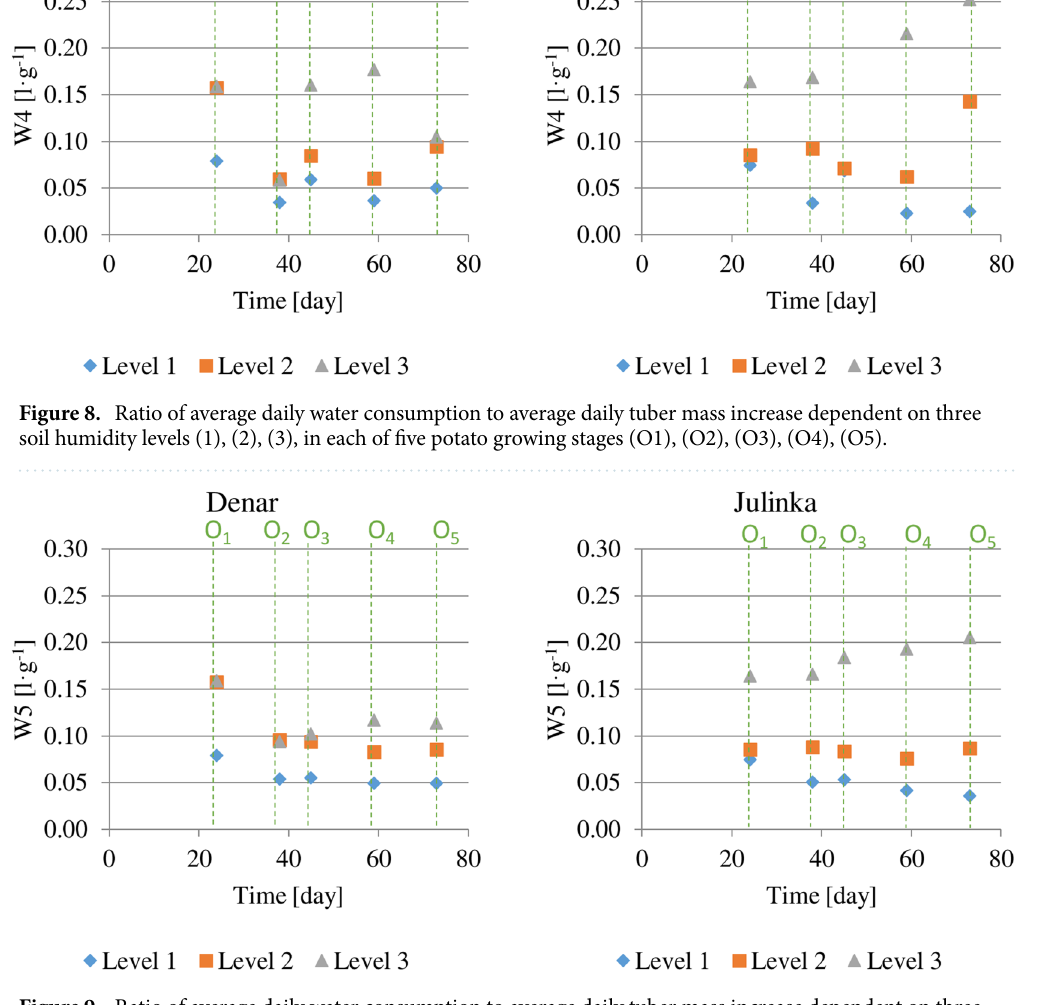
Figure 9. Ratio of average daily water consumption to average daily tuber mass increase dependent on three soil humidity levels (1), (2), (3), cumulative calculation from potato